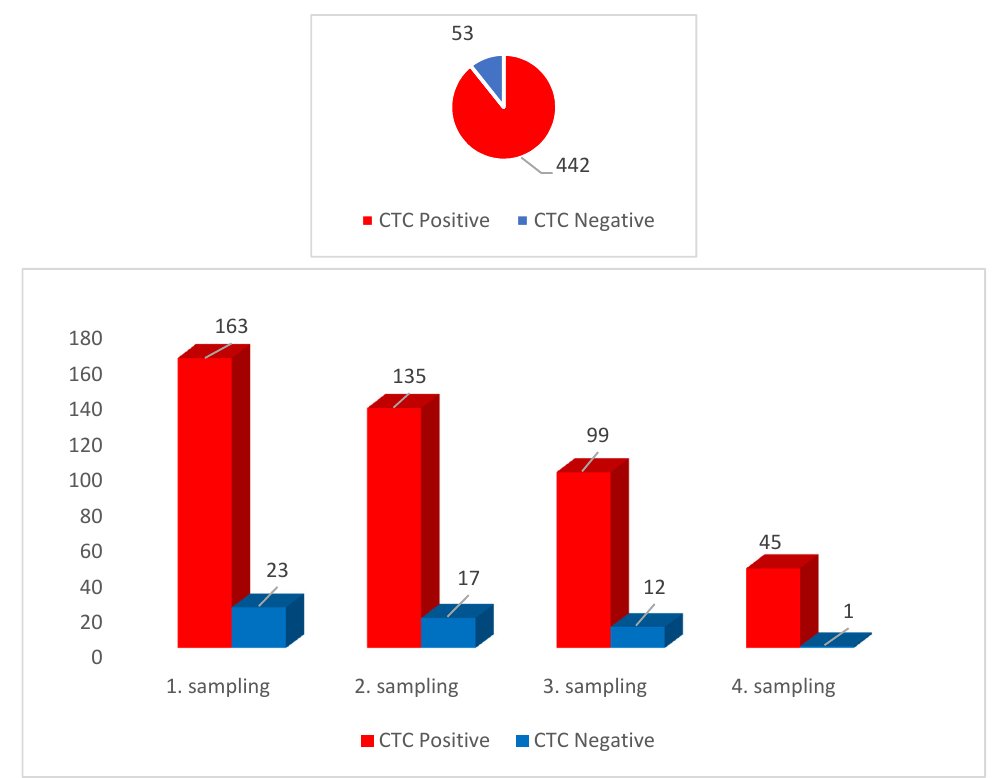
Figure 2. Circulating tumor cells (CTCs) detected in renal cell cancer (RCC) patients for one-year follow-up in four blood samplings. All together 495 samples (in duplicates) were evaluated, with an average 86.6% CTC positivity